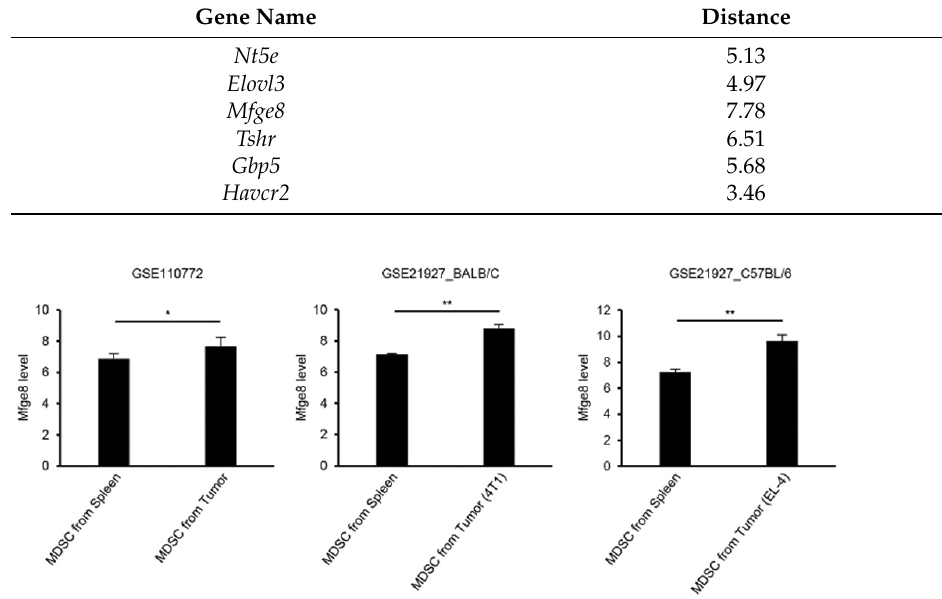
Figure A1. Mfge8 expression is increased in tumor-infiltrated MDSCs. Mfge8 expression in tumor- infiltrated MDSCs in the GEO datasets GSE110772 and GSE21927. Data are expressed as the mean ± SD. * p < 0.05 and ** p < 0.01 by two-tailed t -test.